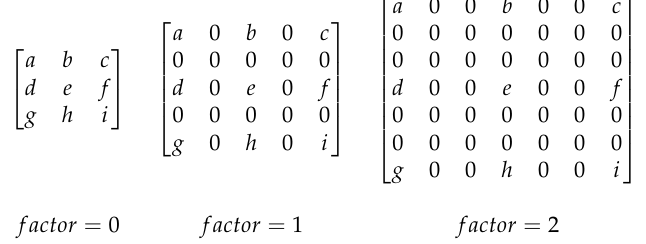
Figure 3. General kernel dilated with different